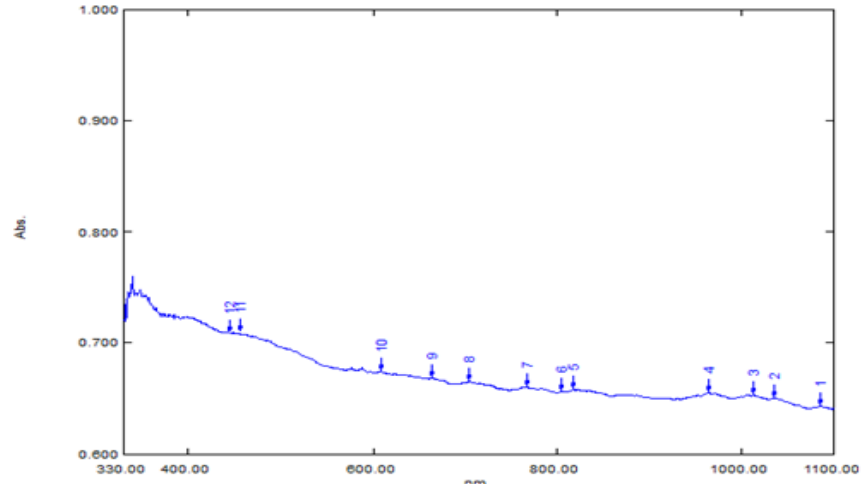
Fig.4: The UV ــ VIS absorption spectra of S-WCNTs DI water suspension at volume fraction 6x10 -5